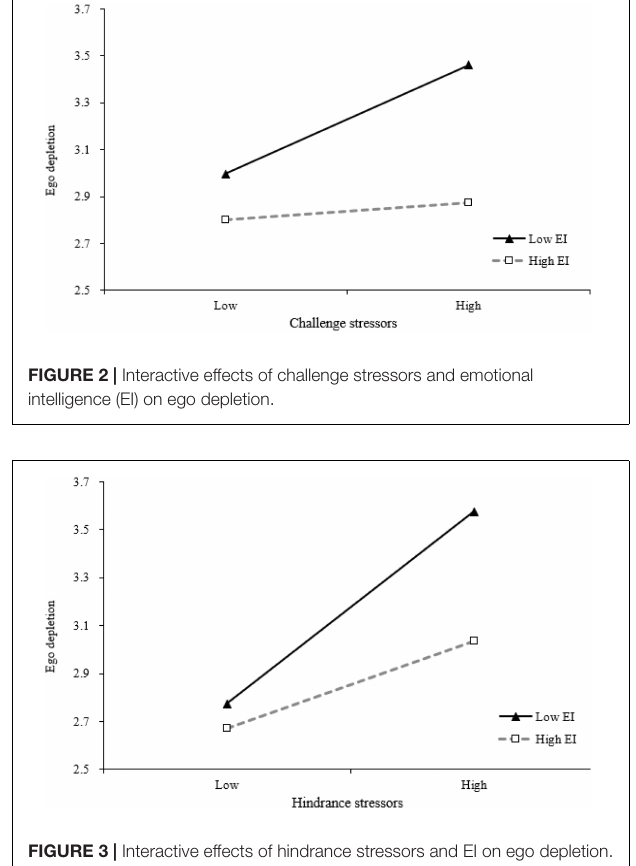
FIGURE 3 | Interactive effects of hindrance stressors and EI on ego depletion.